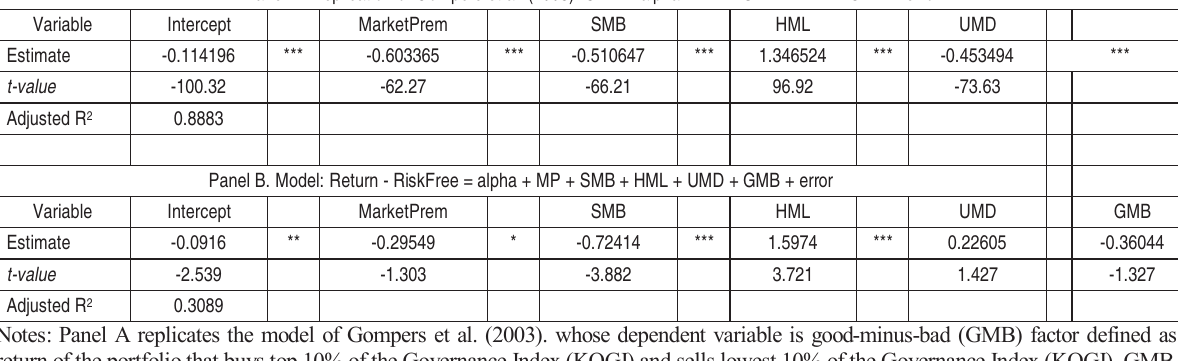
Table 2. Regression results (original